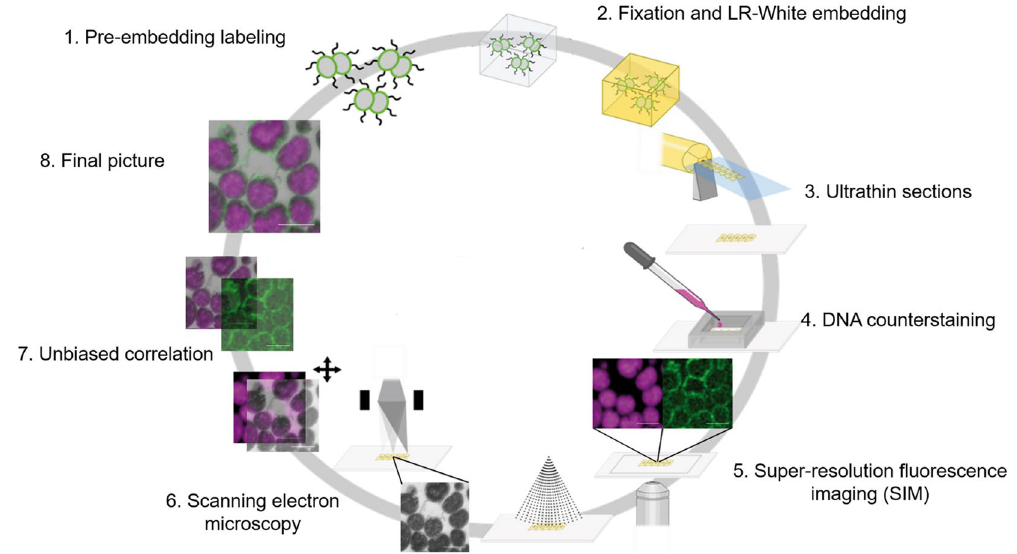
Figure 2. Scheme of the click-AT-CLEM workflow. The scheme shows a breakdown of most important steps in the click-AT-CLEM workflow used in this study. Green: lipids; magenta: DNA; grey: SEM. Scheme was adapted from Markert et al. 17